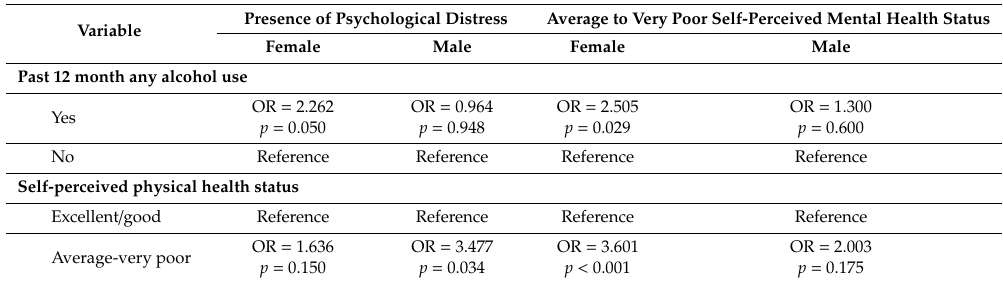
Table 5. Odds ratio of factors a associated with the presence of psychological distress and low self-perceived mental health status, by